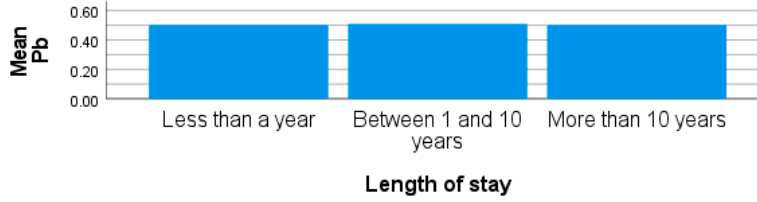
Figure 5. Showing blood Pb by length of stay in obese females living around site 3.